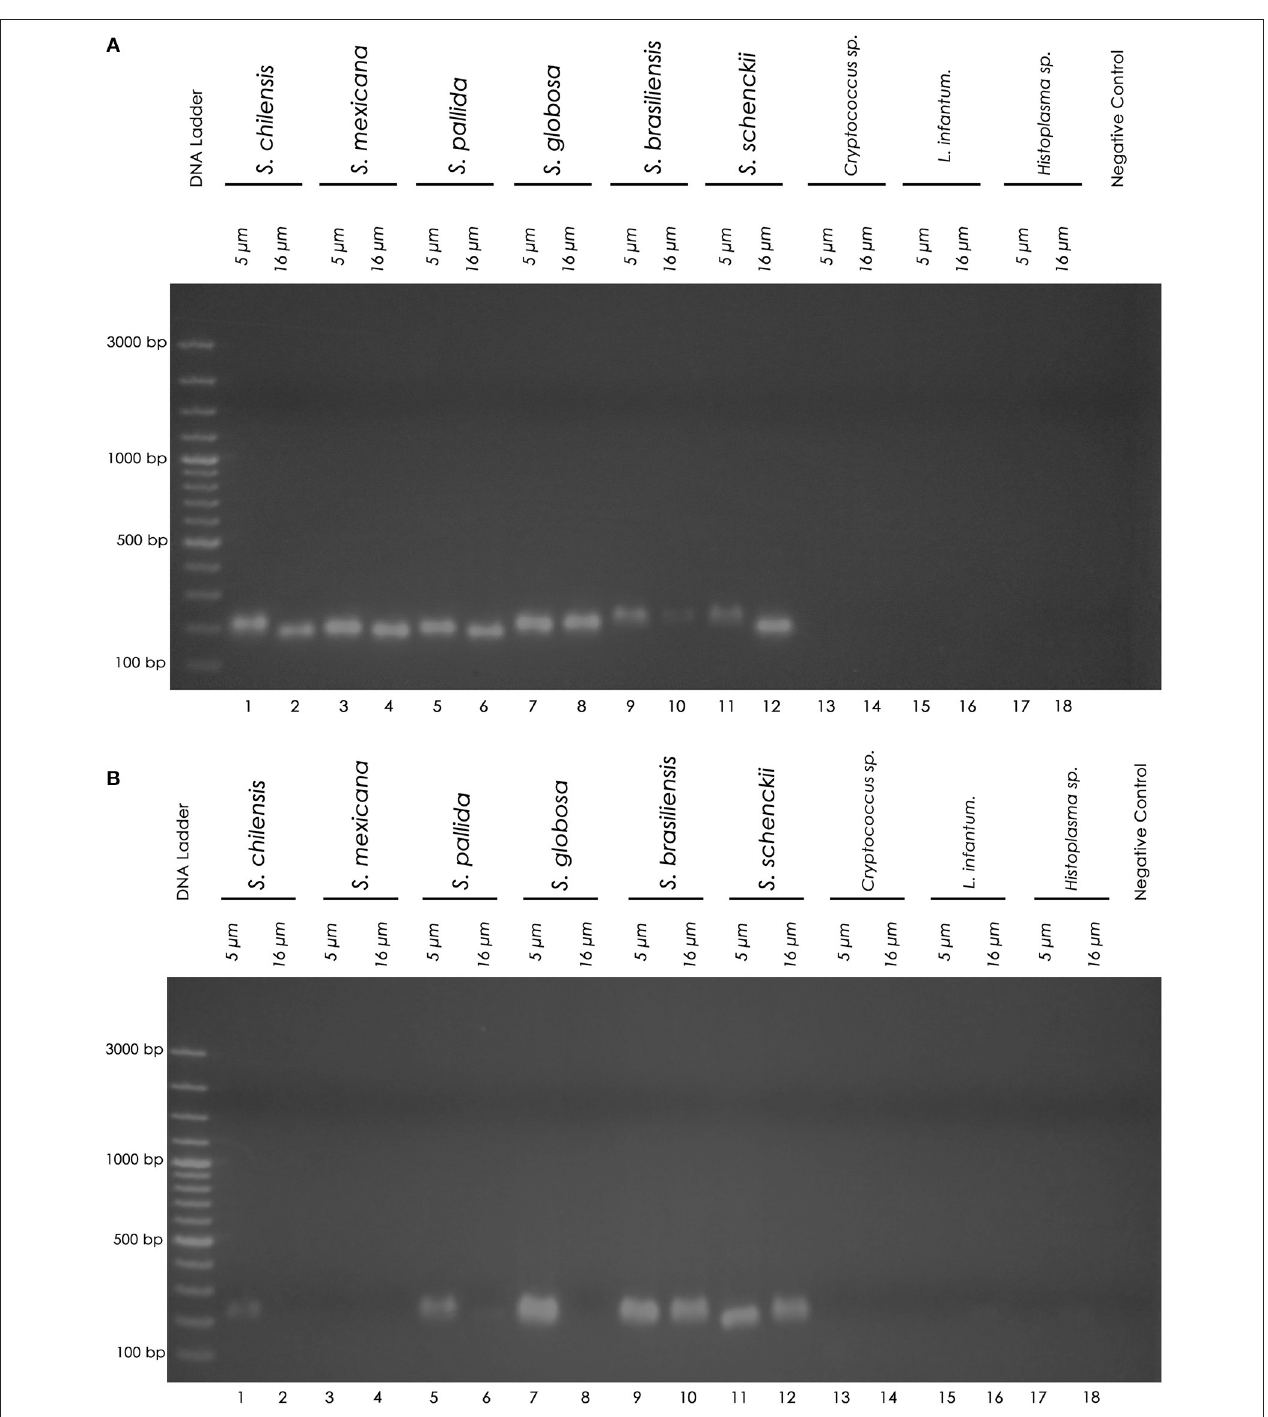
FIGURE 1 | Nested PCR products on agarose gel. (A) Chemical DNA extraction. (B) Thermal DNA extraction. Left to right: Molecular marker DNA ladder, 100 bp (Fermentas). 1 (5 µ m) and 2 (16 µ m): S. chilensis ; 3 (5 µ m) and 4 (16 µ m): S. mexicana ; 5 (5 µ m) and 6 (16 µ m): S. pallida ; 7 (5 µ m) and 8 (16 µ m): S. globosa ; 9 (5 µ m) and 10 (16 µ m): S. brasiliensis ; 11 (5 µ m) and 12 (16 µ m): S. schenckii ; 13 (5 µ m) and 14 (16 µ m): Cryptococcus sp.; 15 (5 µ m) and 16 (16 µ m): L. infantum ; 17 (5 µ m) and 18 (16 µ m): Histoplasma sp.; PCR negative control (sterile water). The nested PCR product is a 152 base pair (152 bp)